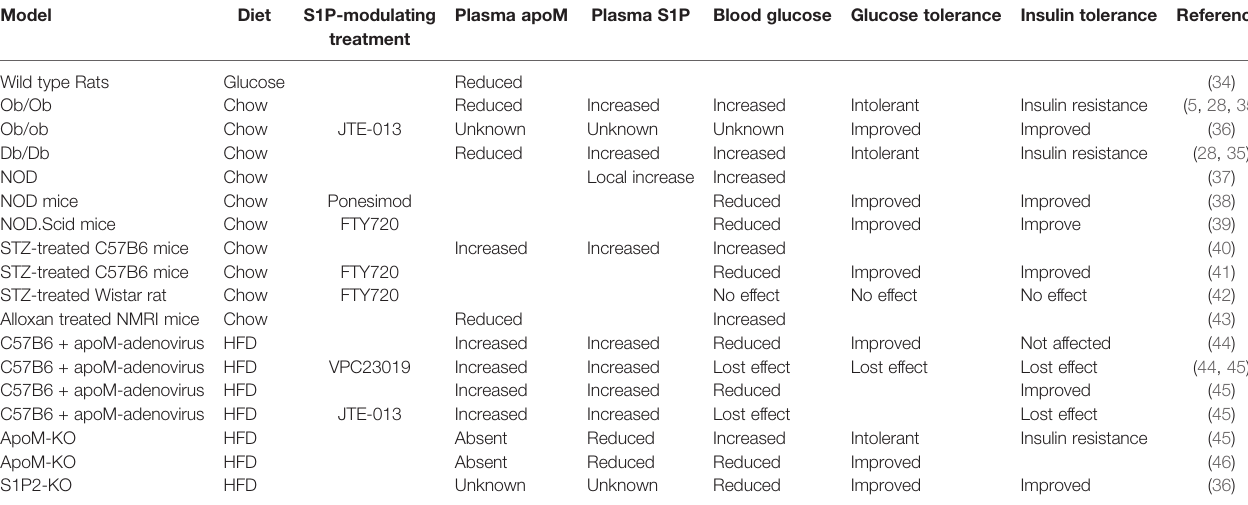
TABLE 1 | Overview of the experimental animal models and the effect on either plasma apoM and S1P or effects on insulin and glucose metabolism.